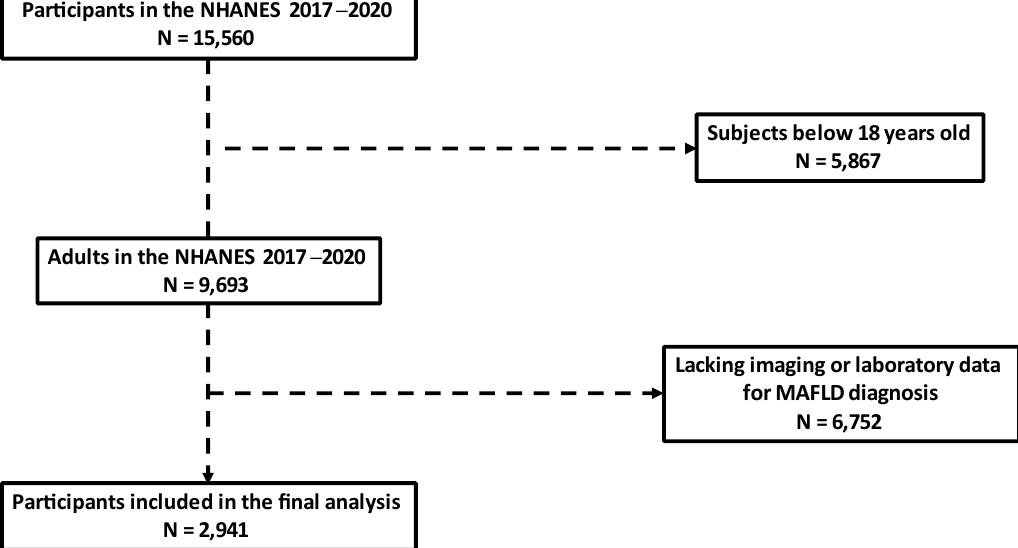
Nutrition Examination Survey. MAFLD: metabolic dysfunction–associated fatty liver Figure 1. Flow chart of the study population inclusion process. NHANES: National Health and Nu- trition Examination Survey. MAFLD: metabolic dysfunction – associated fatty liver disease.